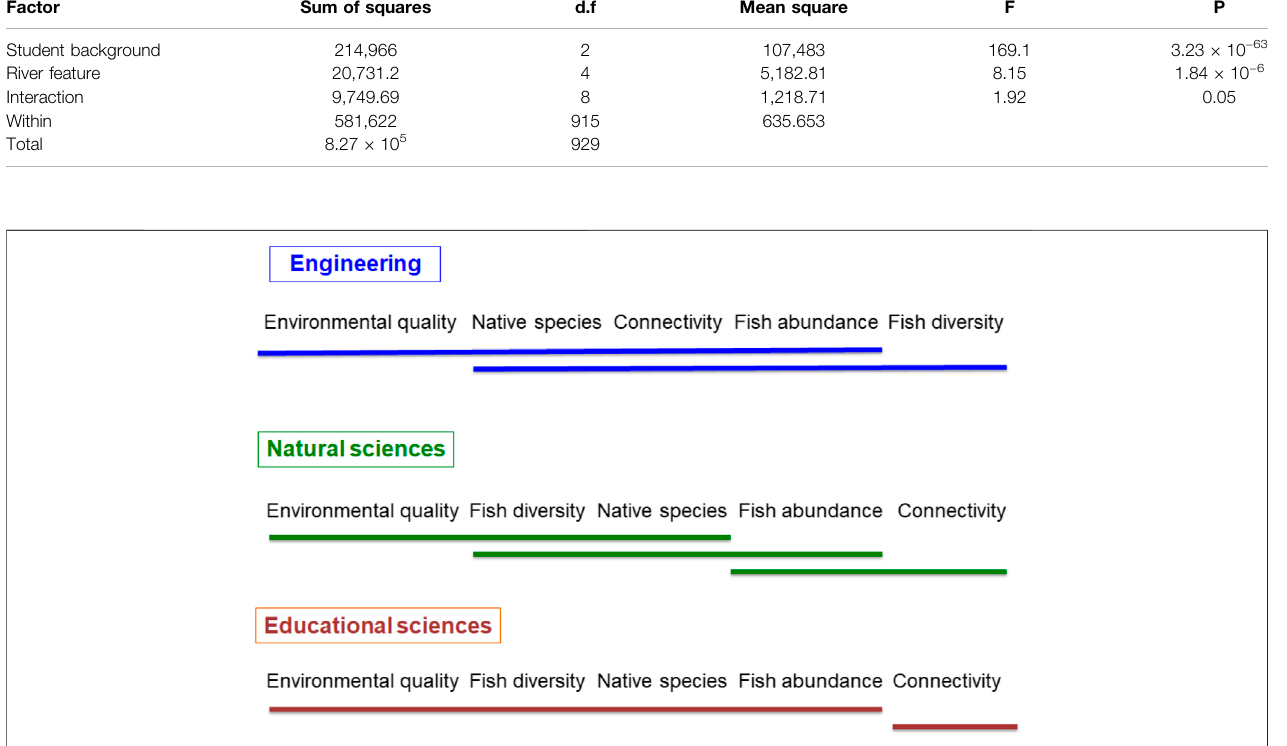
FIGURE3| Post-hocanalysisofpublicappreciationofriverfeatures.Groupsofriverfeaturesnotsigni fi cantlydifferentforwillingnesstopay(frompairwisetests)are underlined.